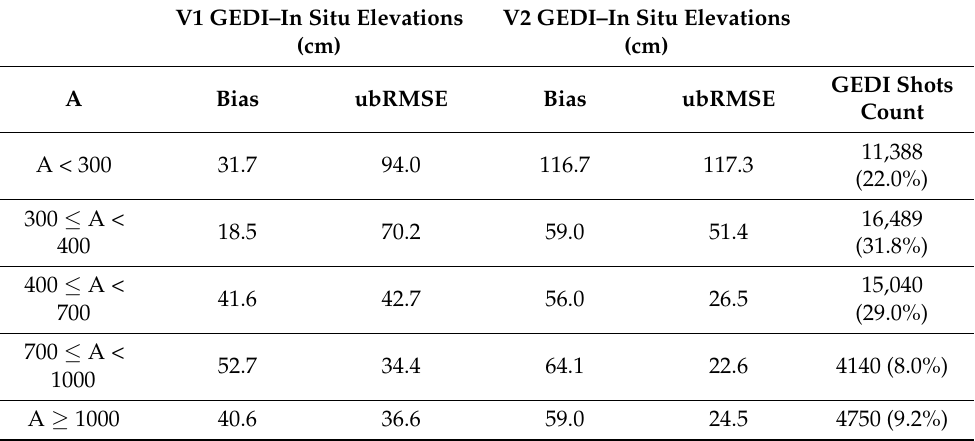
Figure 6. Difference between GEDI and in situ elevations as a function of the amplitude of the water-surface mode. V1 and V2 refer respectively to GEDI elevations from the first and second data releases. Table 2. Summary statistics of the difference between GEDI and in situ elevations according to the five classes of the GEDI water-surface mode amplitude (A).